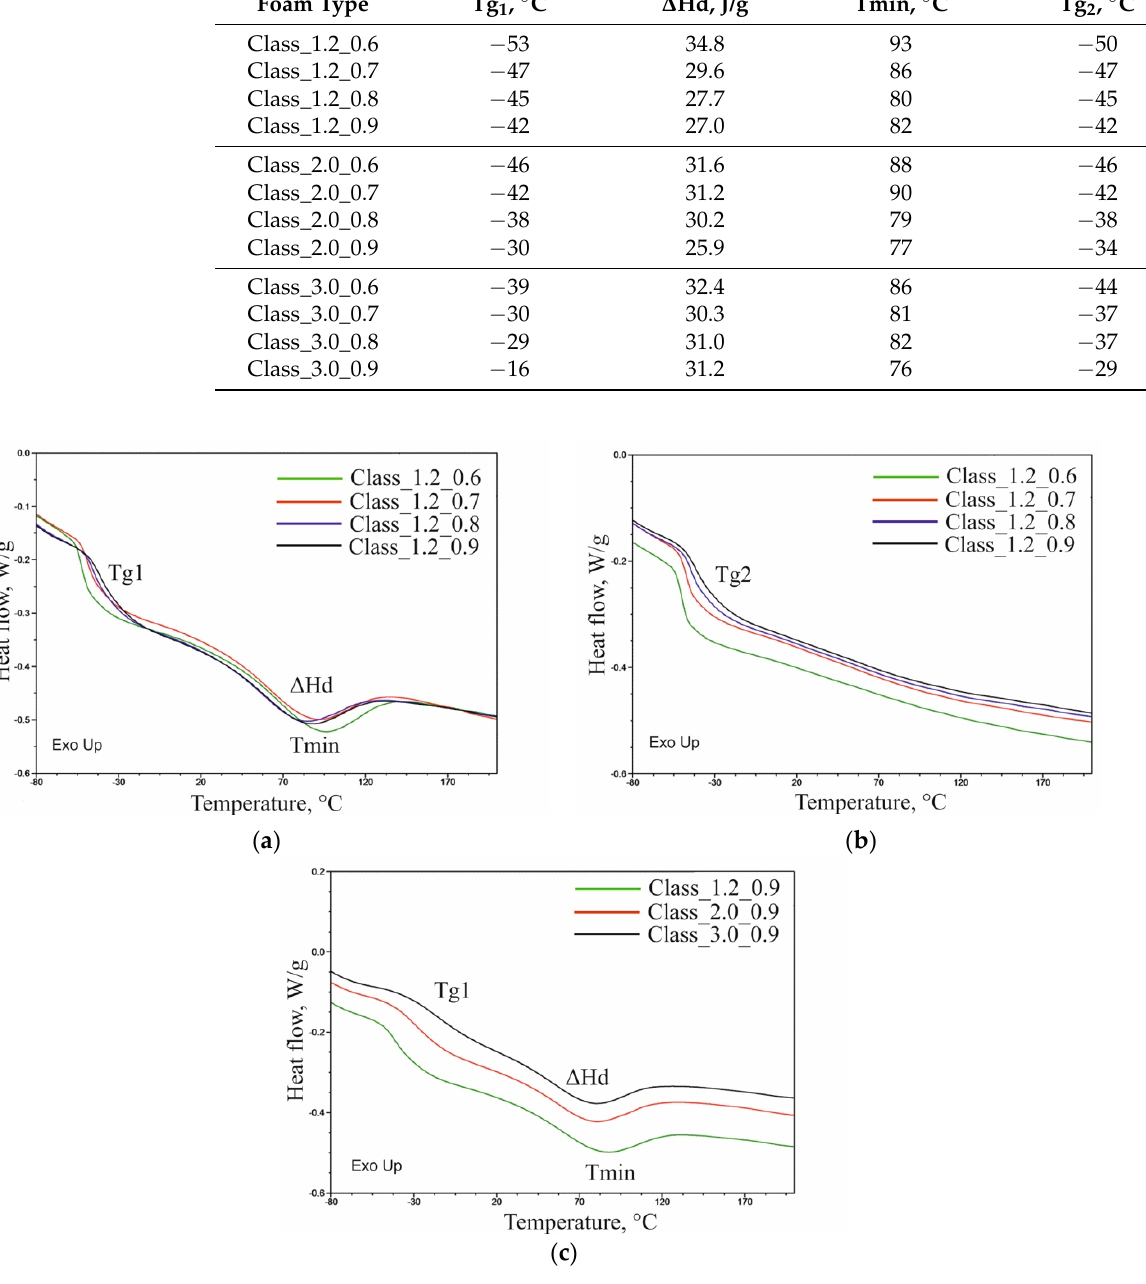
Figure 5. DSC thermograms obtained: ( a ) in the first heating cycle for Class_1.2_0.6–0.9 foams, ( b ) in the second heating cycle for Class_1.2_0.6–0.9 foams, and ( c ) in the first heating cycle for Class_1.2–3.0_0.9 foams.